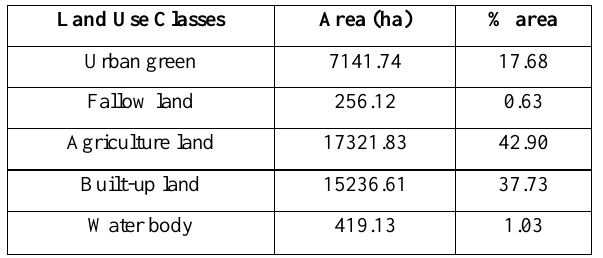
Figure 5: Change Map